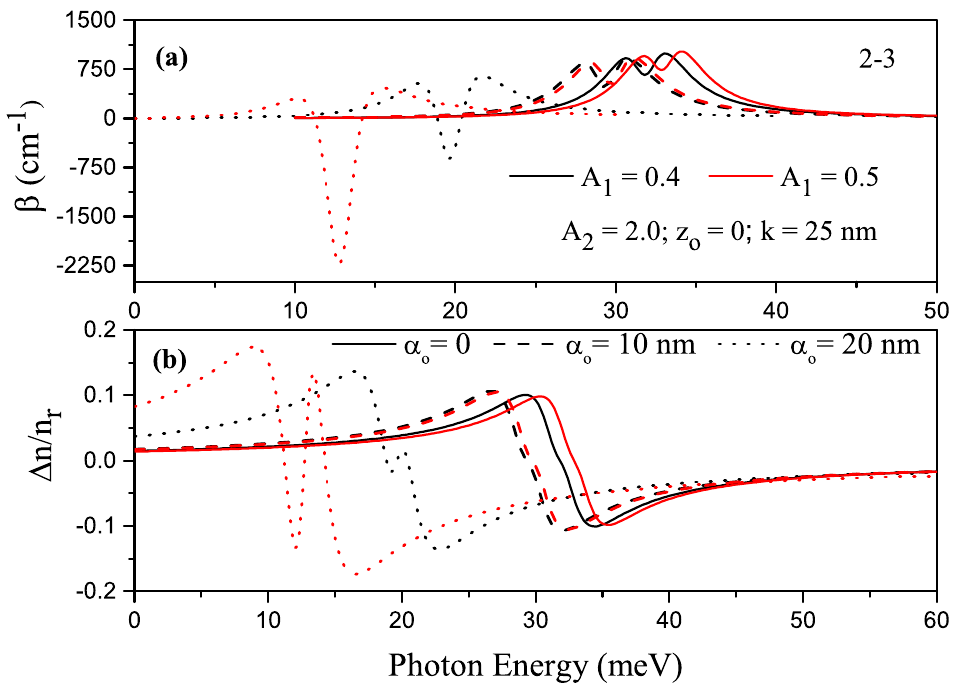
Figure 5. For k = 25nm, A 2 = 2.0 and z o = 0, ( a ) variation in the total absorption coefficient versus the photon energy corresponding to the ( 2-3 ) transition in parabolic–Gaussian symmetric DQW; ( b ) variation in the total refractive index versus the photon energy, where black (red) curves are for A 1 = 0.4 ( A 1 = 0.5 ) and solid, dashed, and dotted curves are for α o = 0, α o = 10nm, and α o = 20nm,